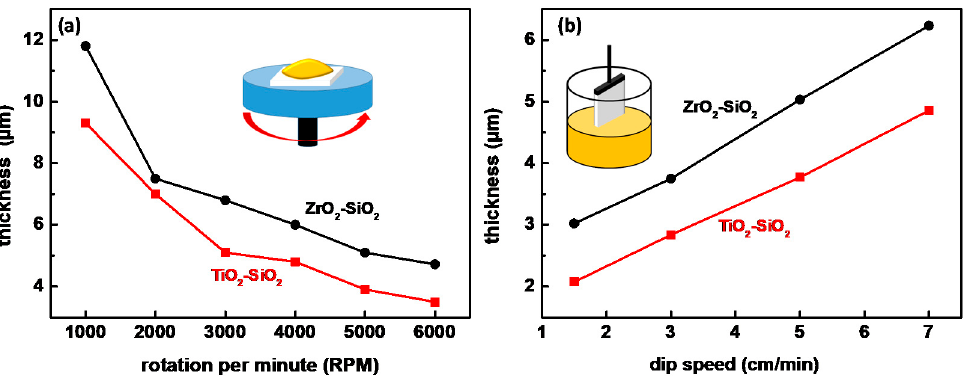
Figure 5. Investigation of TiO 2 –SiO 2 (red squared curve) and ZrO 2 –SiO 2 (black dotted curve) thicknesses using the spin coating ( a ) and the dip coating ( b ) methods.